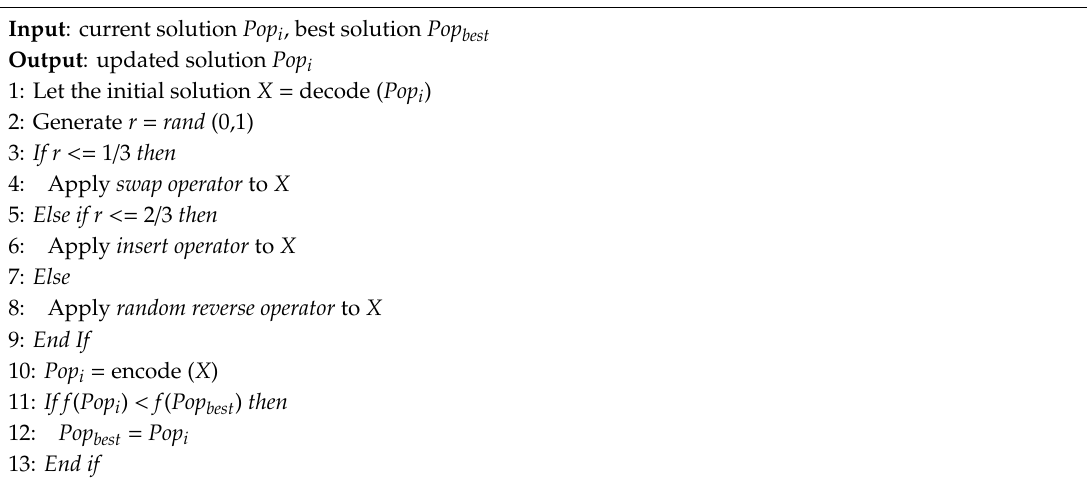
Algorithm 2 Local search